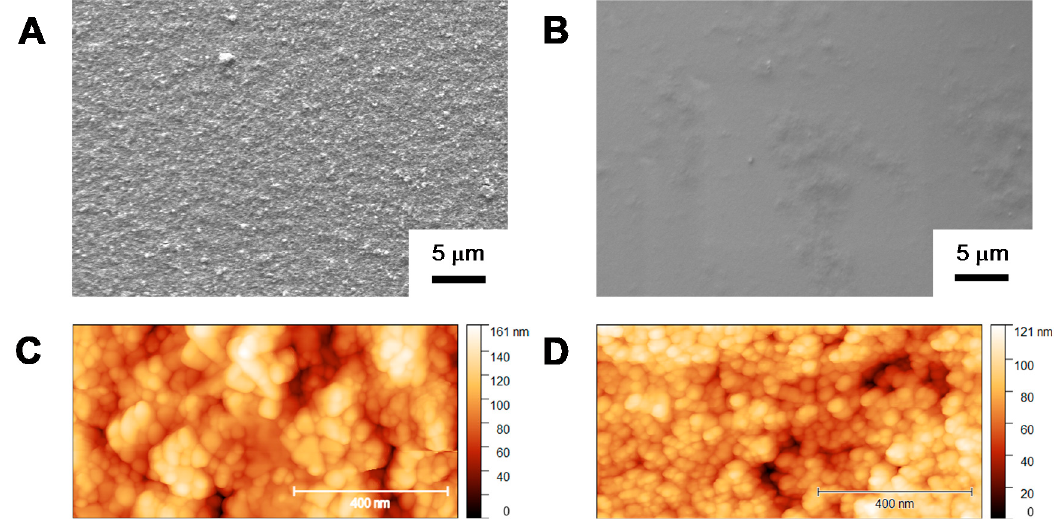
Figure 2. SEM micrographs ( A , B ) and AFM images ( C , D ) of NiO electrodes of type A ( A , C ) and type B ( B , D ).